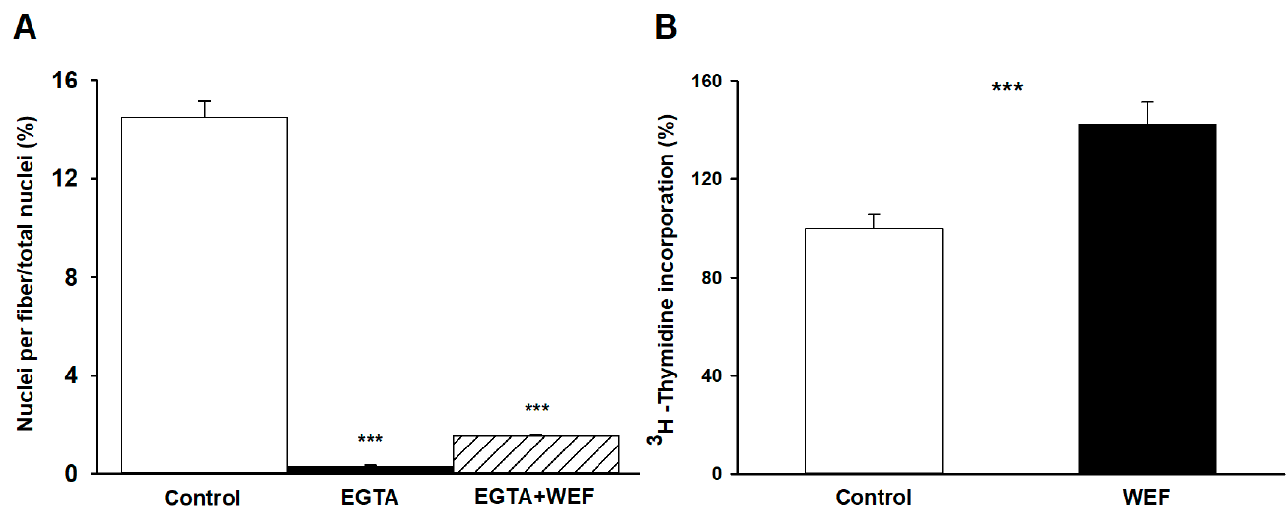
Figure 2. Effect of EGTA on myoblast differentiation and WEF on thymidine incorporation. ( A ) Presence of nuclei in myotubes in absence (Control) or presence of EGTA (1.8 mM), or EGTA + WEF for 24 h. In this series, experiments began 40 rather than 48 h after plating. Values are mean ± range for 3 dishes. *** p < 0.001 vs. Control. ( B ) Cells were grown with 3 H-thymidine under control conditions for 24 h ( ) or exposed to WEF for 24 h ( (cid:4) ). Values are mean ± SE for seven dishes. *** p < 0.001 between groups.